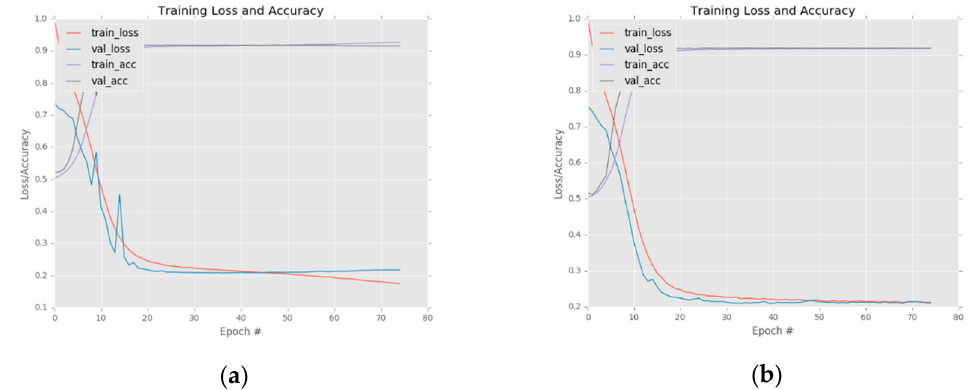
Figure 5. The loss and accuracy of the training process with data enhancement on the PETA dataset: ( a ) without data enhancement; and ( b ) with data enhancement.